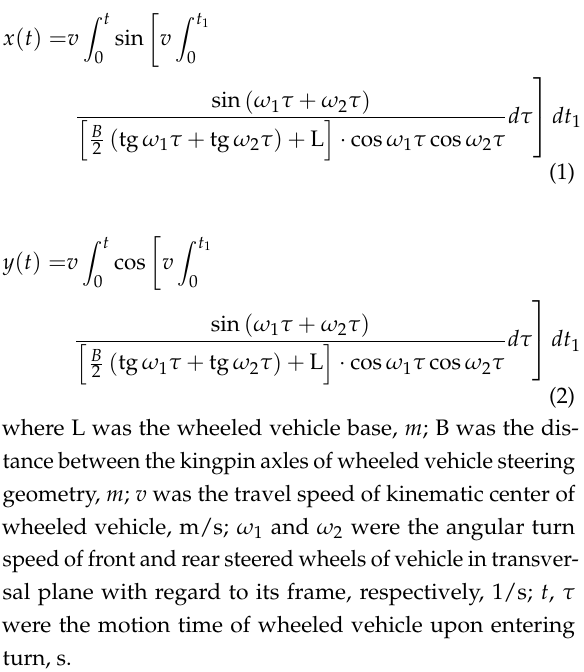
= 0.28 1/ s , ω = 0 1/ s 2 1